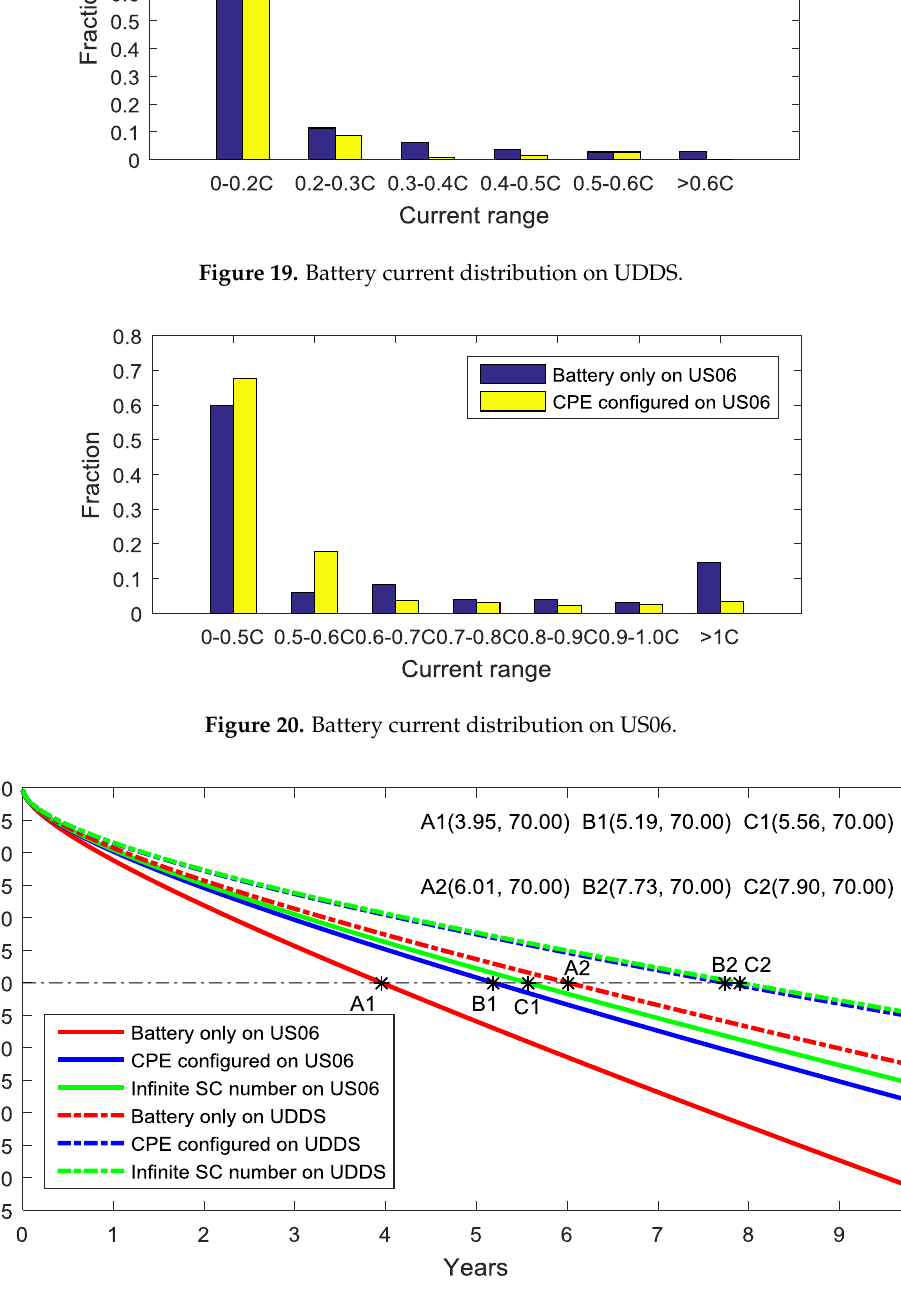
Figure 21. Battery degradation results.